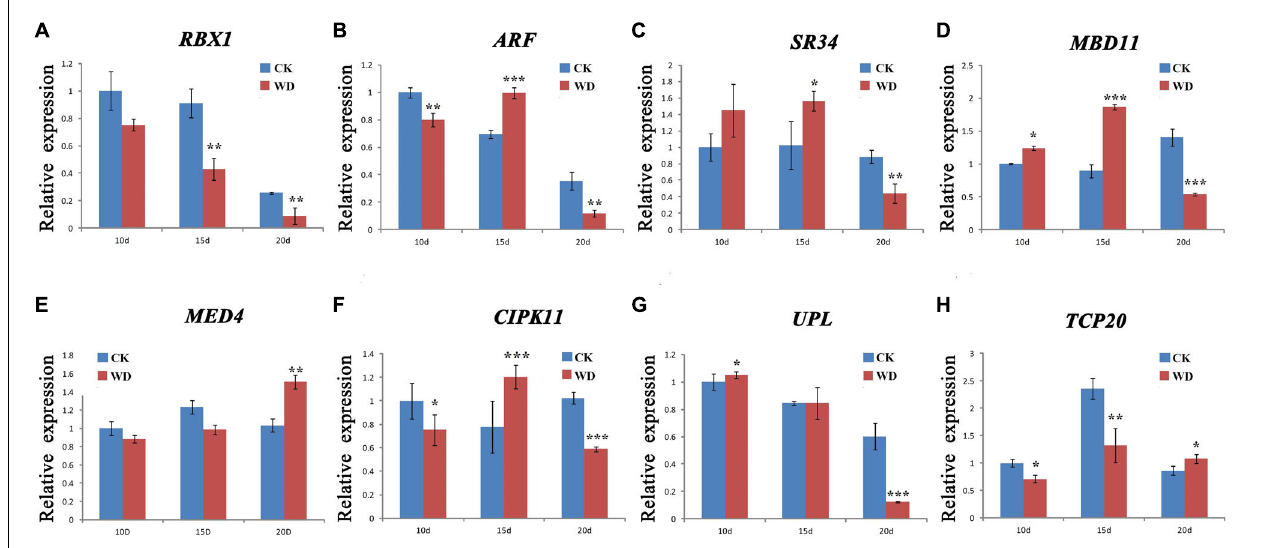
FIGURE 5 | qRT-PCR analysis of eight representative differentially accumulated proteins (DAPs) encoding genes in nuclear-enriched fraction of Zhongmai 175 grain under water deficit. (A) RBX1, E3 ubiquitin-protein ligase RBX1; (B) ARF, Auxin response factor; (C) SR34, Serine/arginine-rich-splicing factor SR34 isoform X3; (D) MBD11, Methyl-CpG-binding domain-containing protein 11; (E) MED4, Mediator of RNA polymerase II transcription subunit 4; (F) CIPK11, CBL-interacting protein kinase 11; (G) UPL,putative E3 ubiquitin-protein ligase SINA-like 6; and (H) TCP20, transcription factor TCP20. Statistically significant differences were calculated based on an independent Student’s t -tests: * p < 0.05; ** p < 0.01; and *** p < 0.001. CK, control; WD, water deficit.